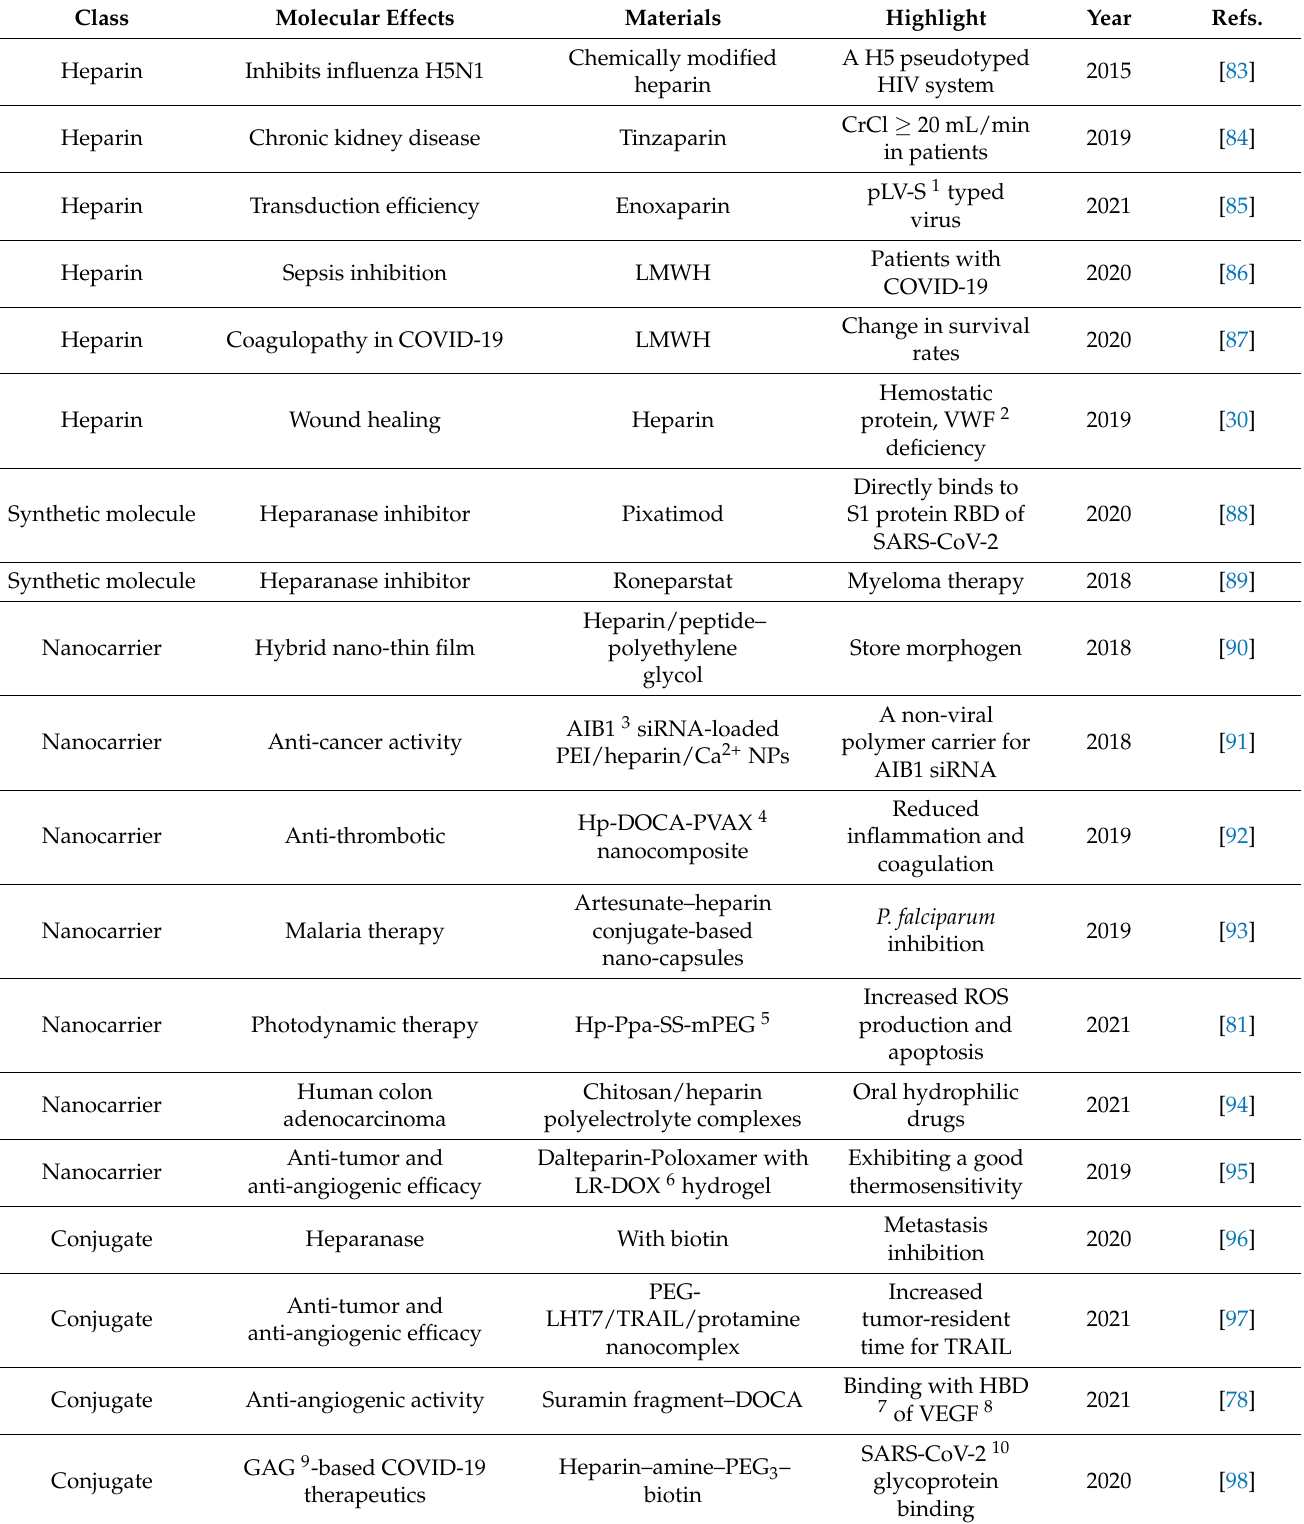
Table 1. Recently developed heparin-based biomolecules for the treatment of various